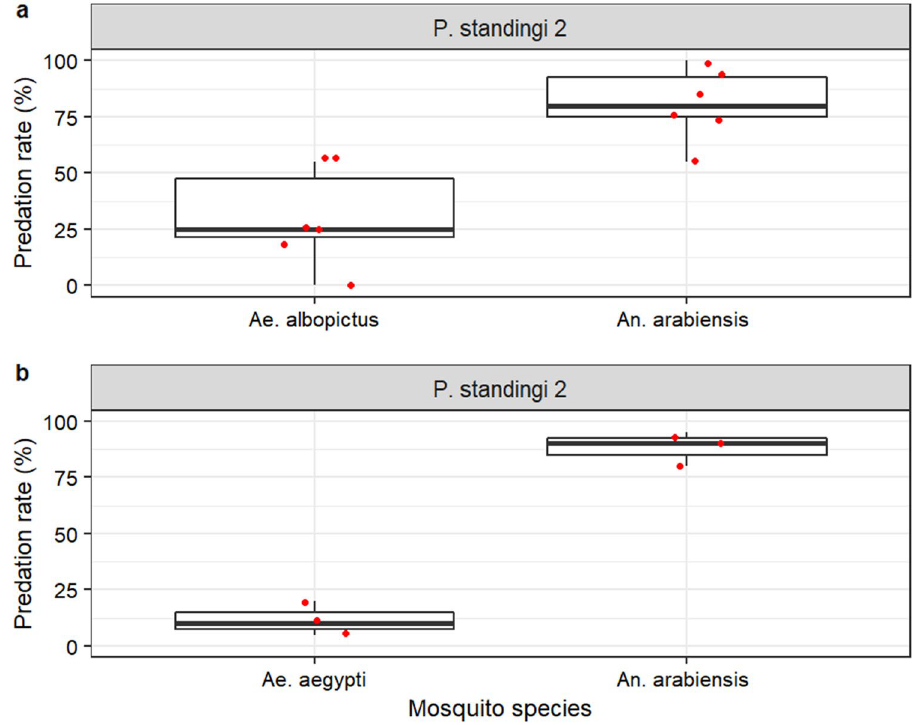
Figure 6. Phelsuma standingi predation preference for Aedes or Anopheles mosquitoes. ( a ) Ae. albopictus versus Anopheles arabiensis; ( b ) Ae. aegypti versus Anopheles arabiensis .